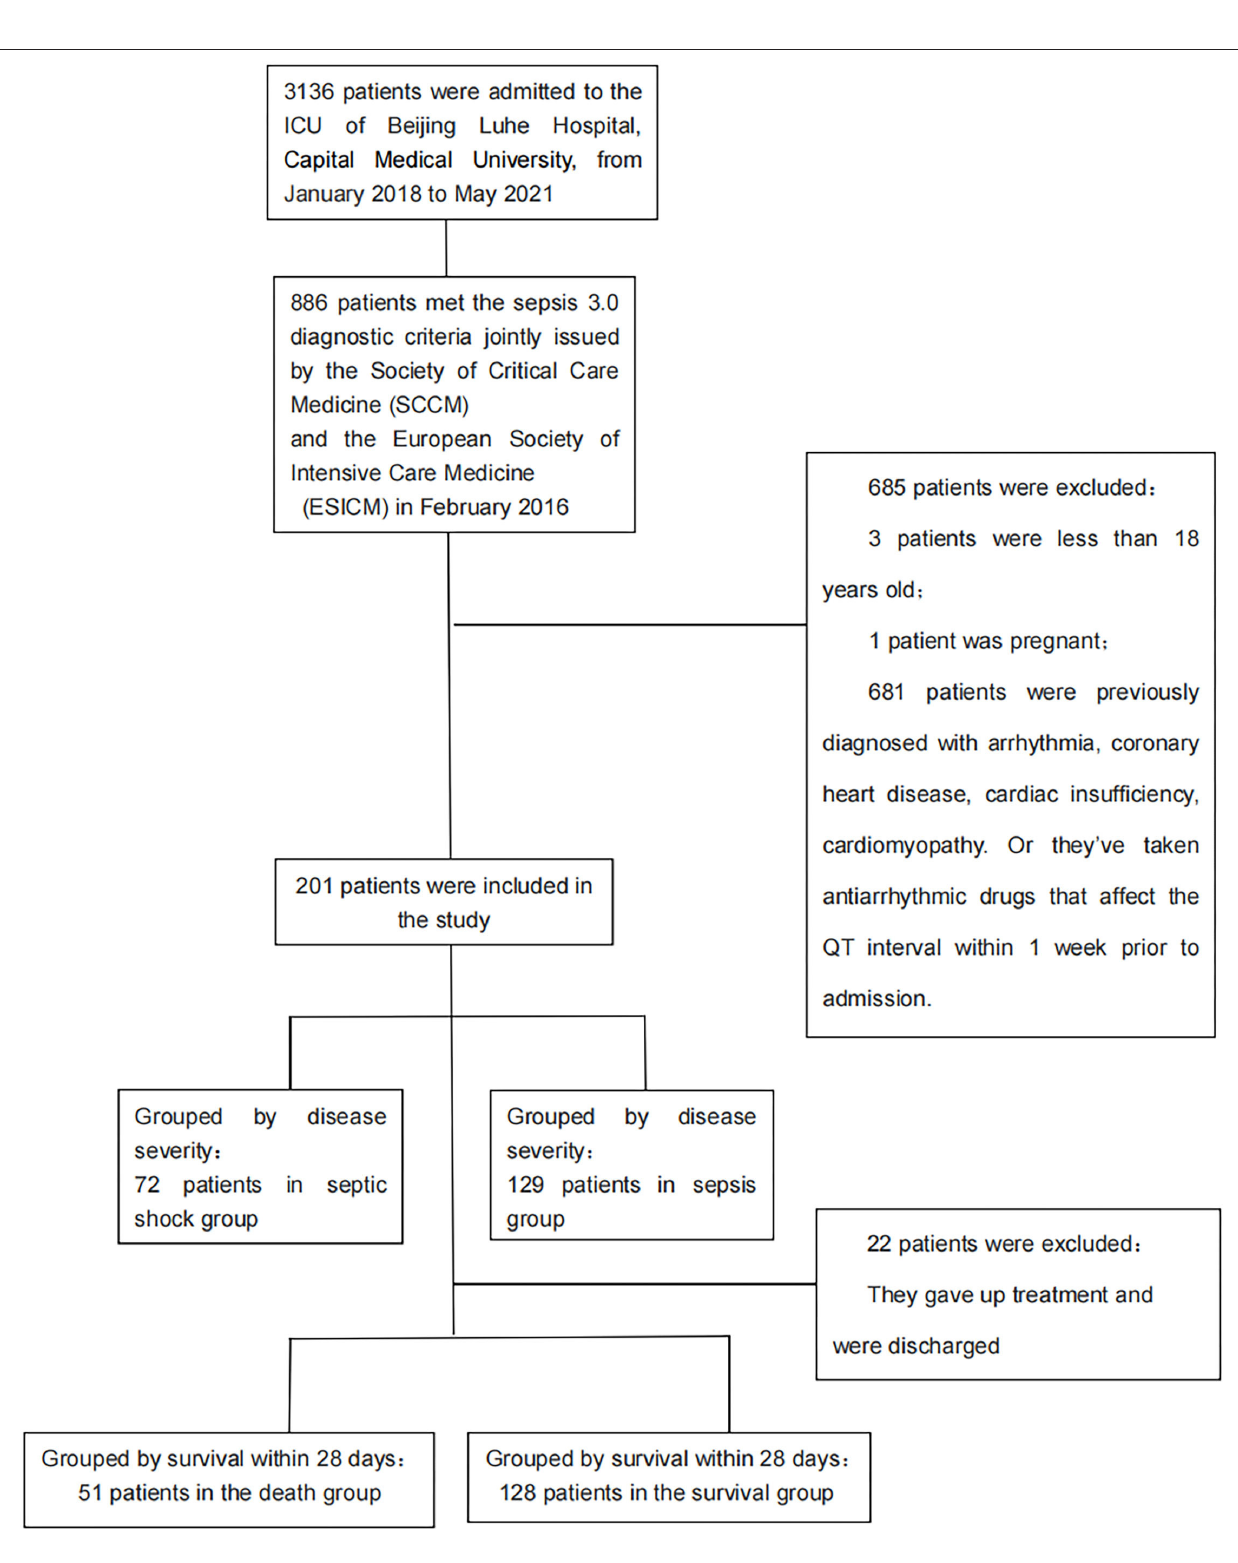
Frontiers in Cardiovascular Medicine |